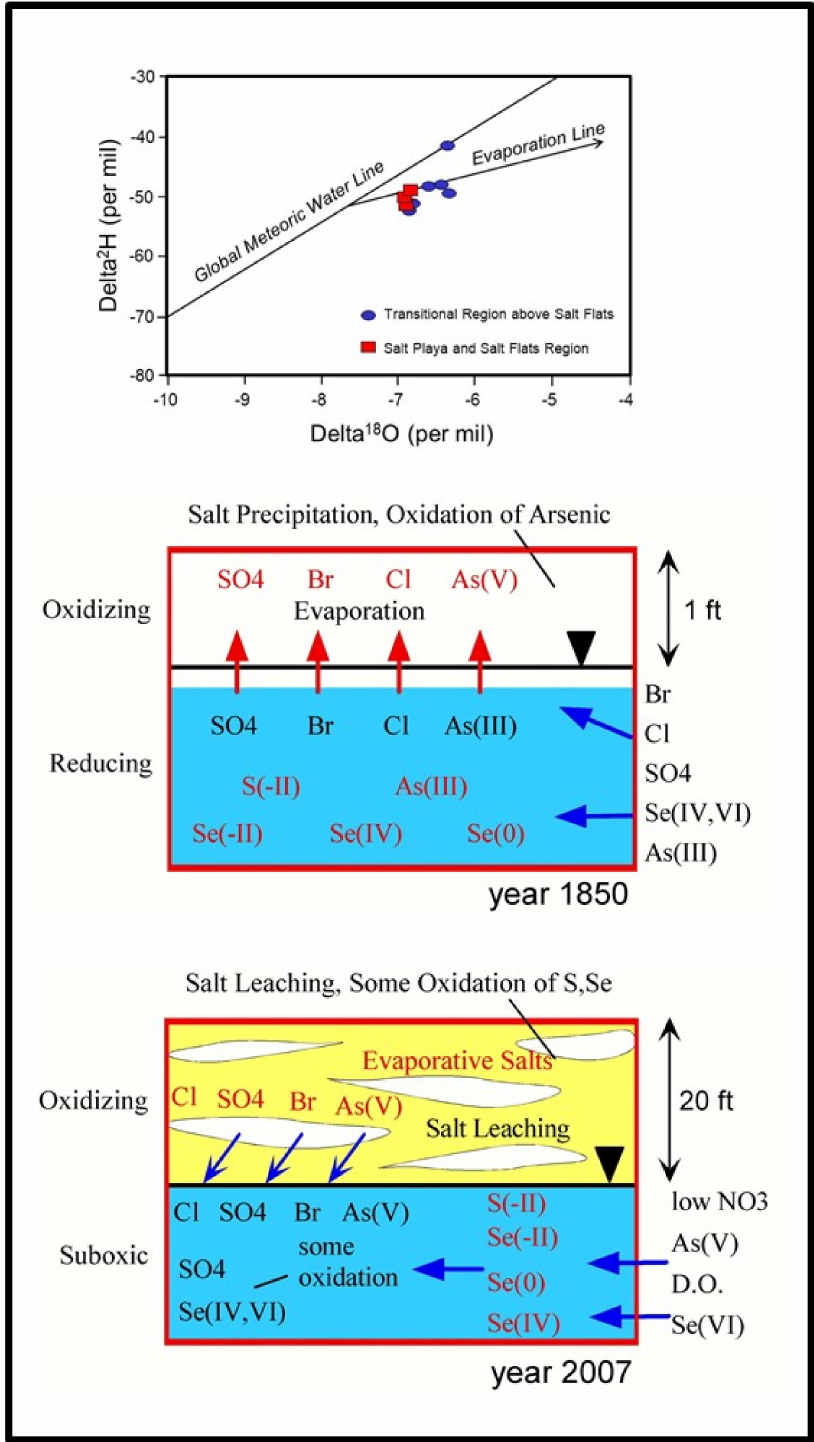
Figure 11. Stable isotope data for groundwater from Edinger Drain, showing the evaporation line that defines most shallow groundwater in San Diego Creek Watershed [34]. Groundwater within the Transitional Swamp Region and Historical Salt Flats is usually isotopically similar. This means that saline groundwater within the salt flats forms from dissolution of salts during aquifer recharge, and not due to pure evaporation of groundwater. The conceptual model for this leaching process, pre-and-post drainage of the marsh and salt flats (Figure 9), is shown in the model